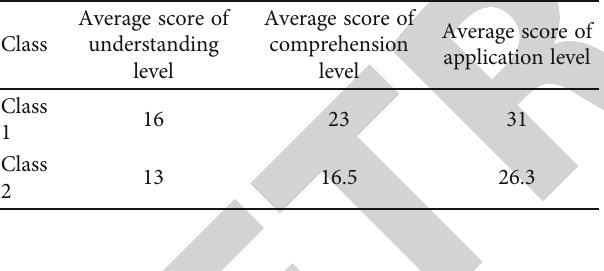
Table 1: Cognitive level comparison analysis table.